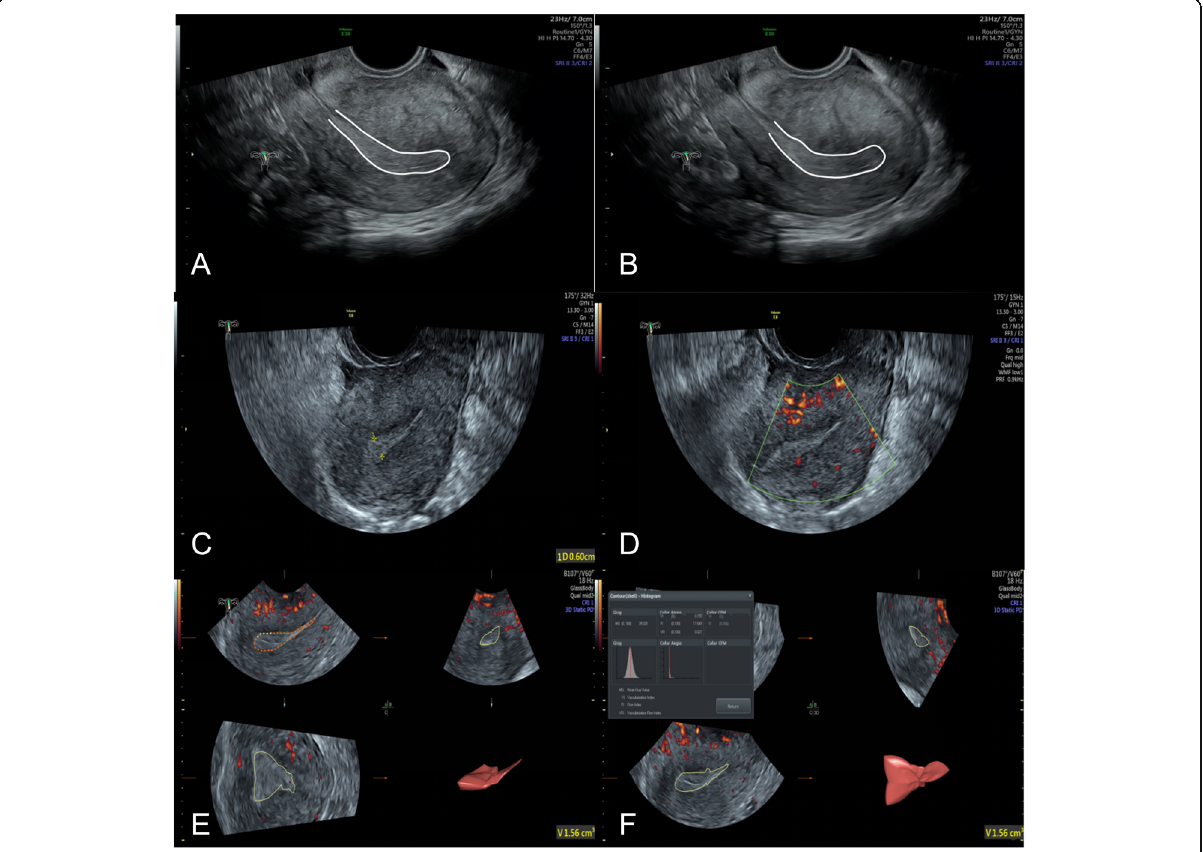
Fig. 3 Ultrasound images of a subject in the AA group. a , b Two-dimensional gray-scale mode; two images during observation. White curve, outline of endometrium. No endometrium peristalsis wave within 3 min; score, 1; c two-dimensional gray-scale mode; endometrial thickness, 6.0 mm; score, 1; endometrial type, type C; score, 1; d 2D color Doppler mode; a little blood flow in the subendometrium; score, 2; e three- dimensional mode; EV, 1.56 cm 3 ; score, 1; f three-dimensional mode; VFI, 0.027; score,